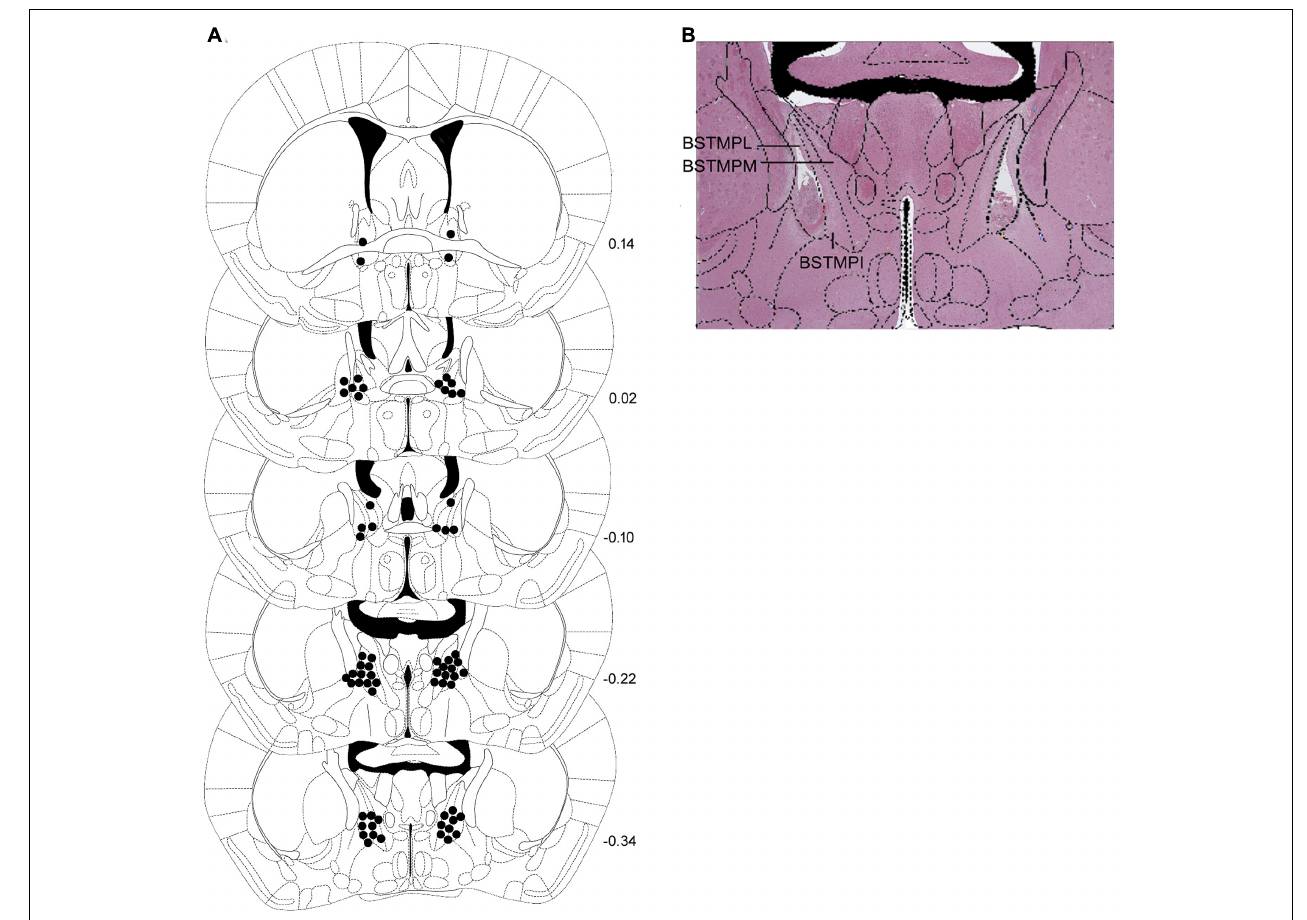
FIGURE 8 | (A) Correct placements of intra-BNST bilateral cannulae in non-stressed controls and stressed mice and (B) representative photomicrograph after hematoxylin-eosin staining. Each diagram corresponds to a coronal section of the mouse brain according to the bregma (Paxinos and Franklin, 2001). The number of points in the figures is less than the total number of animals because of overlapping injection sites. BSTMPI, bed nucleus of the stria terminalis, medial division, posterointermediate part; BSTMPL, bed nucleus of the stria terminalis, medial division, posterolateral part; BSTMPM, bed nucleus of the stria terminalis, medial division, posteromedial